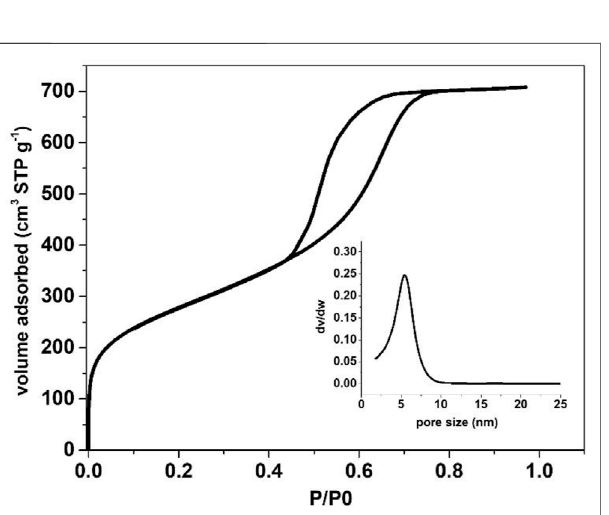
Frontiers in Chemical Engineering |